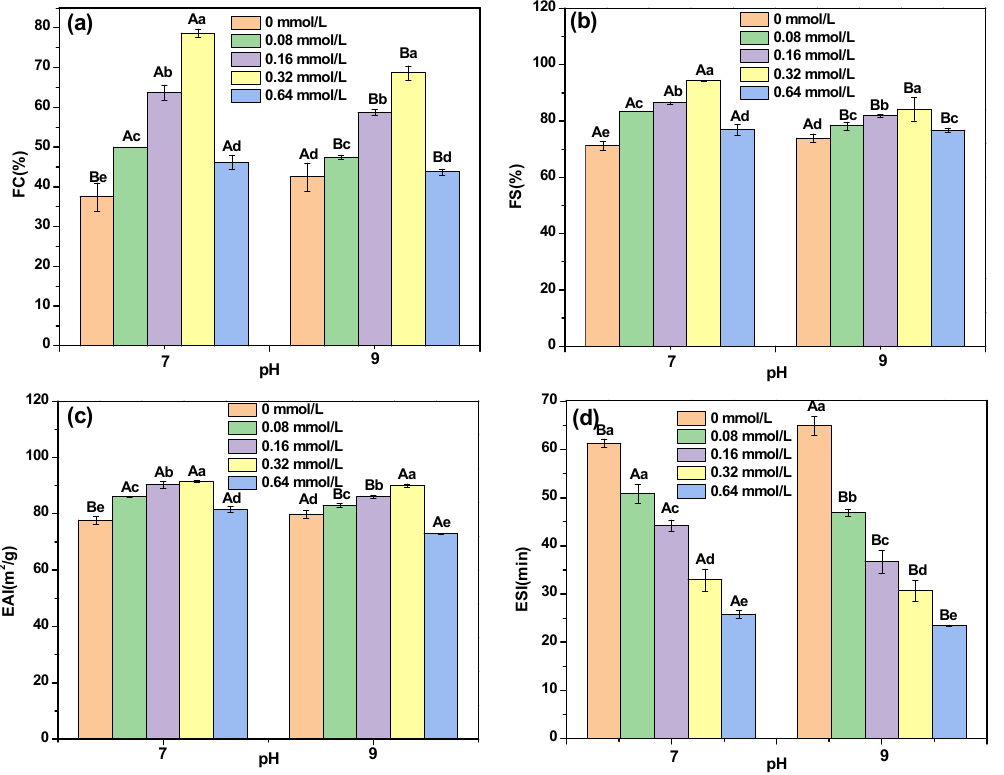
Figure 5. The foaming capacity (FC, ( a )) and foaming stability (FS, ( b )), emulsifying activity index (EAI, ( c )), and emulsifying stability index (ESI, ( d )) of decolorized highland barley protein (DHBP) − proanthocyanidin (PC) complexes. a–e mean values with different letters under the same conditions; A,B mean values with different letters under different conditions, indicating significant differences ( p < 0.05), respectively.